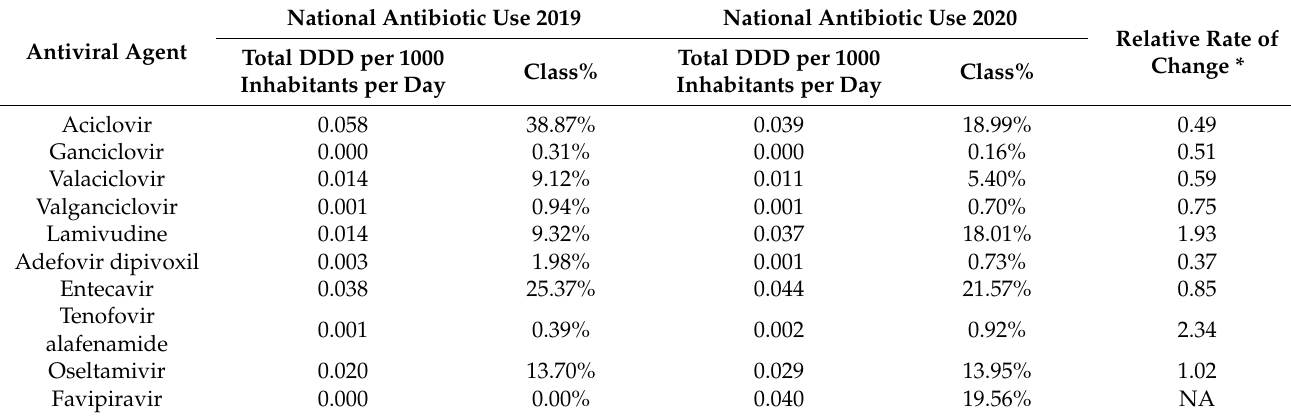
Table 4. National antivirals consumption, expressed in DID (DDD/1000 inhabitants/days) per each agent, for 2019 and 2020,